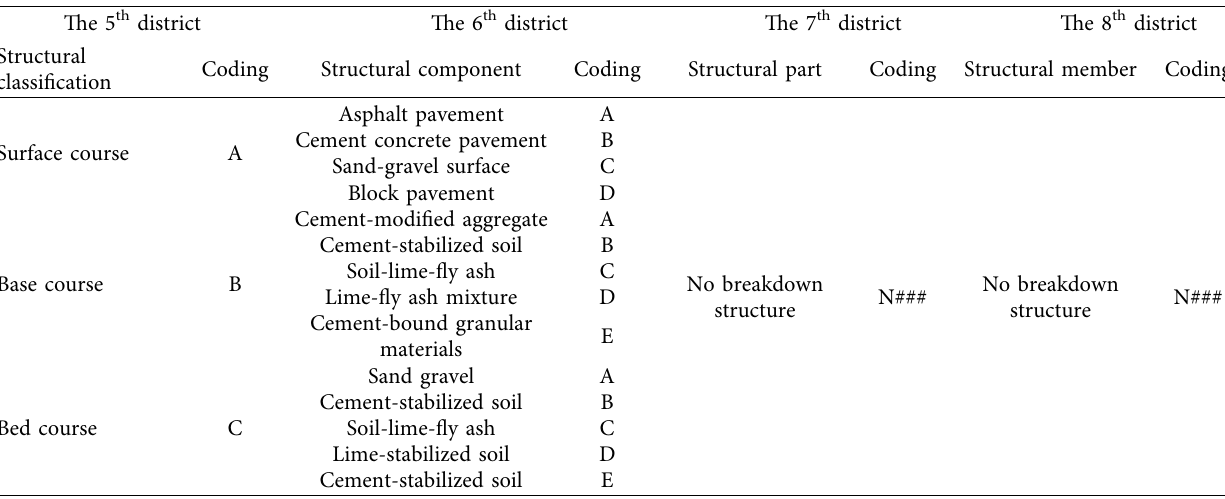
Table 4: Surface EBS Coding (from the 5 th –8 th